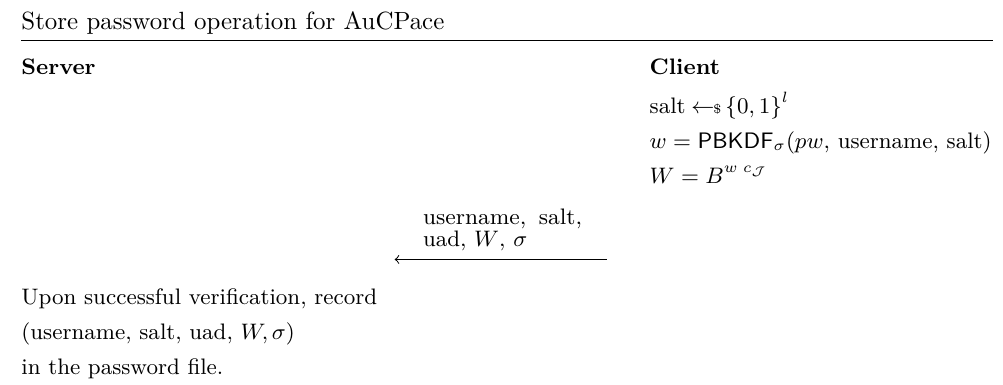
Figure 3: Protocol for password configuration. The optional data element uad represents application data associated with this specific user account, e.g. specifying the granted authorization level on the